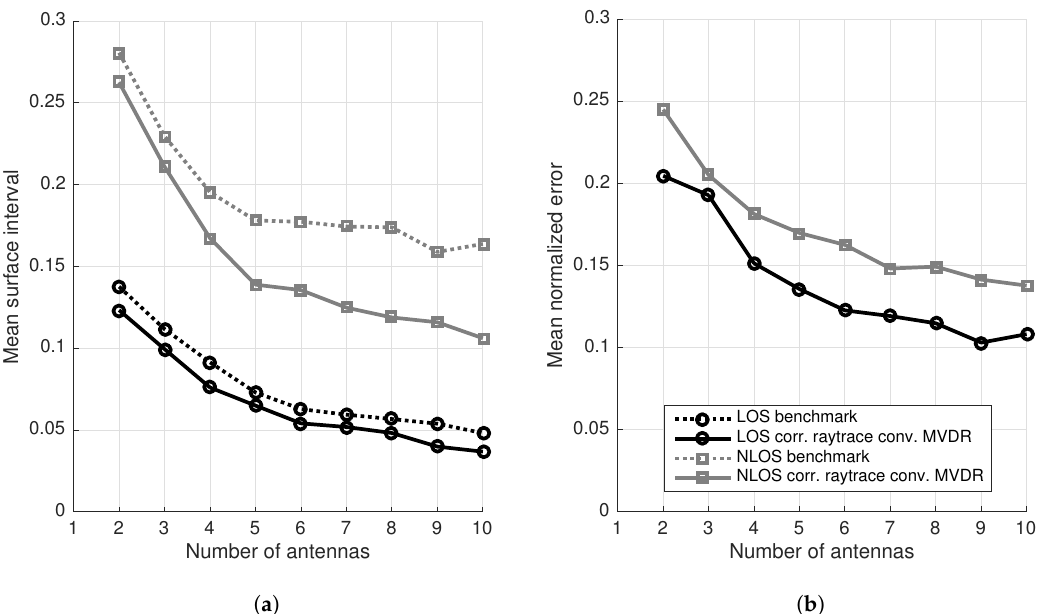
Figure 12. Evaluation of the mean surface interval ( a ) and mean normalized errors ( b ) as a function of the number of array elements ( M